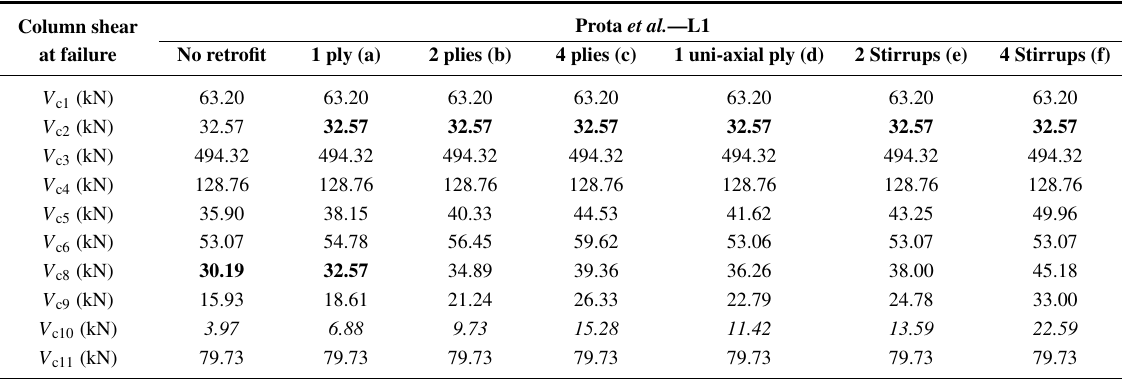
Bold numbers indicate failure considering maximum bond.